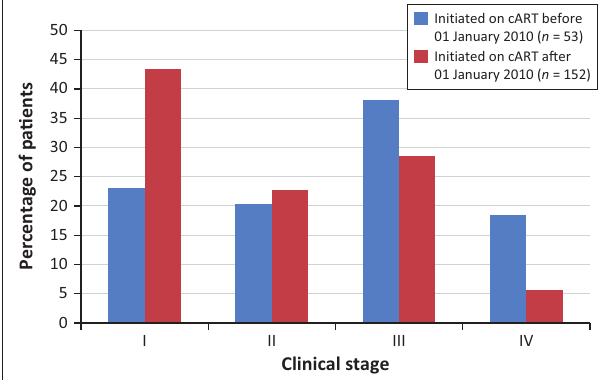
FIGURE 3: Clinical stage at initiation of combination antiretroviral therapy of patients started before 01 January 2010 and those started after 01 January 2010. ( n = 206)